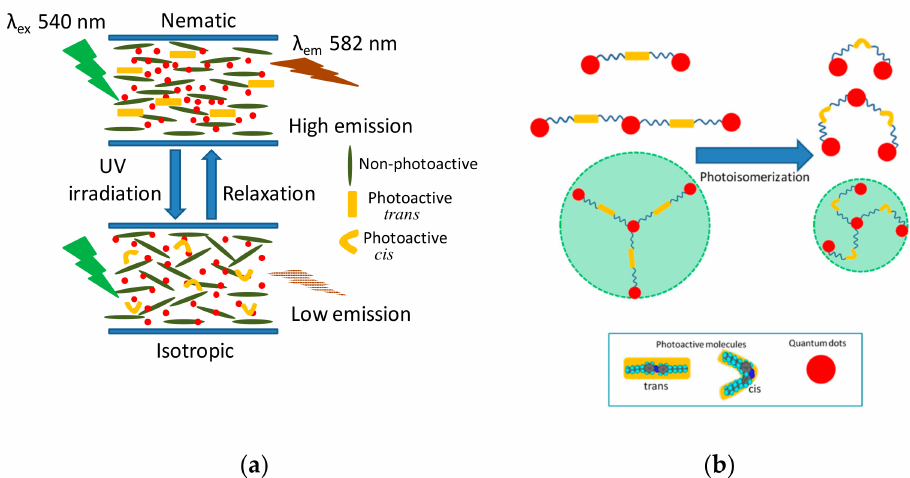
Figure 8. ( a ) Schematic representation of optically driving the fluorescence change from high to low values. The azobenzene derivative responsible for this has an equilibrium rod-shaped trans state, which upon photoisomerization changes to bent cis state. This change in shape of the minority azobenzene molecules drives the entire system isothermally from the nematic to the isotropic phase. Through di ff erent pathways the system returns to the trans isomer of azobenzene, and the equilibrium nematic phase. ( b ) Chemically bound azobenzene and quantum dot system in (i) dimer, (ii) trimer and (iii) star-shaped forms in the equilibrium and photoisomerized states. To be noticed is the size reduction / shape change of the assembly during the